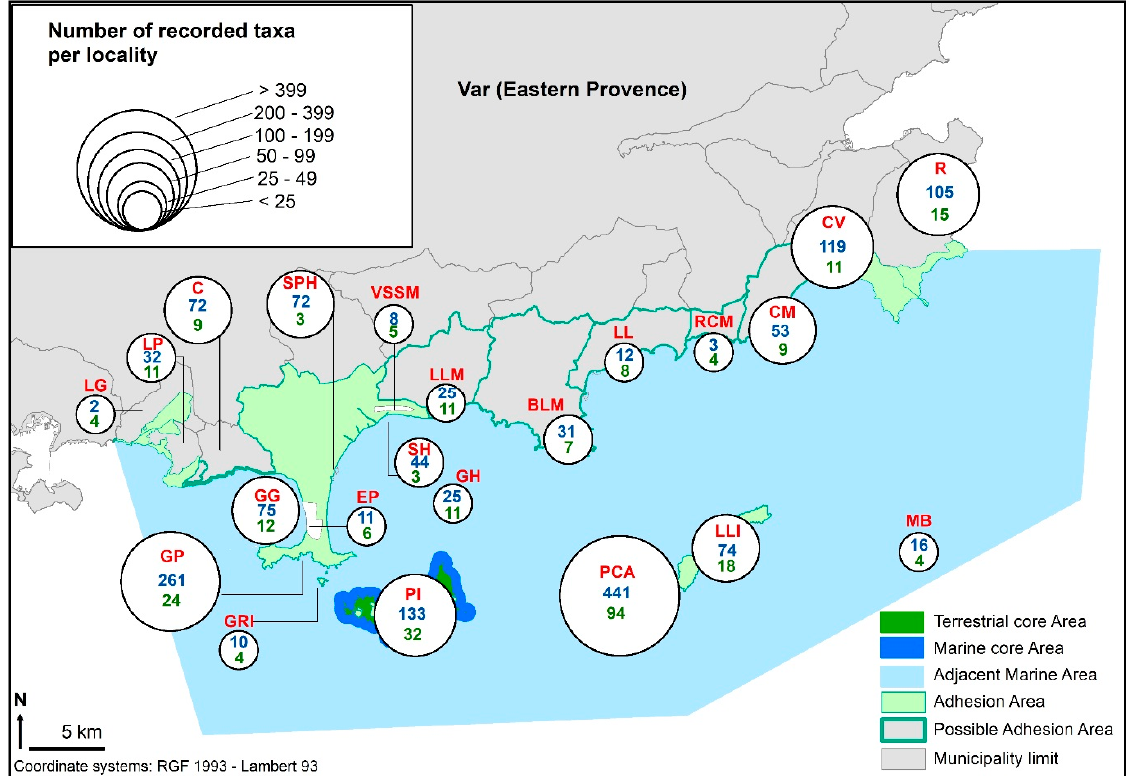
Figure 3. Number of reported taxa (in blue) and literature documents (in green) per locality and site (in red).